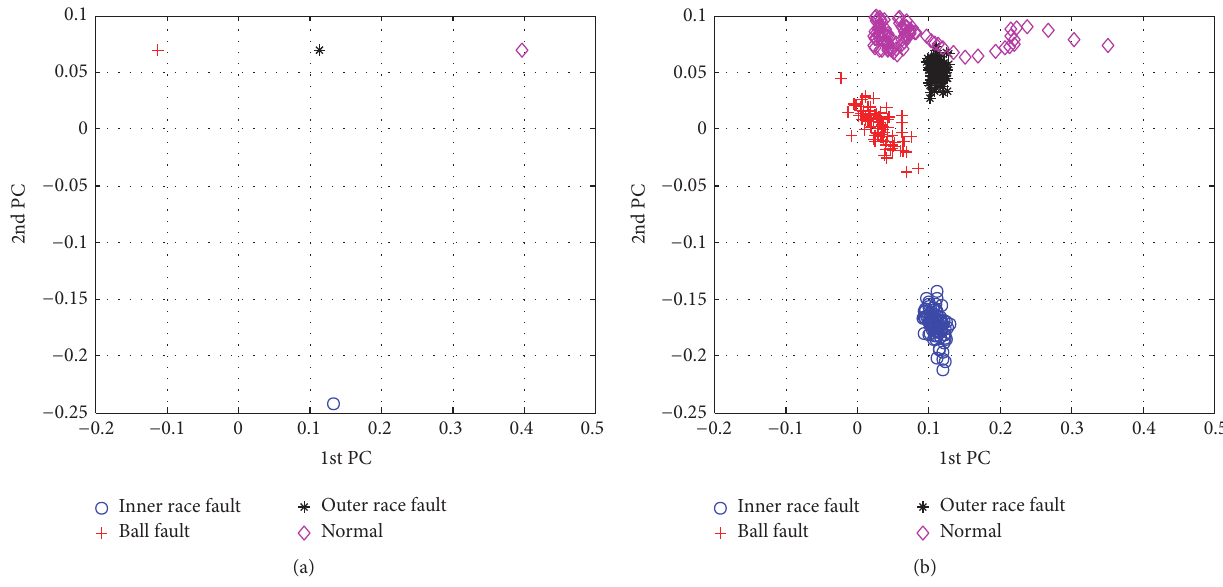
Figure 6: Feature extraction with KFDA: (a) training set and (b) testing set.